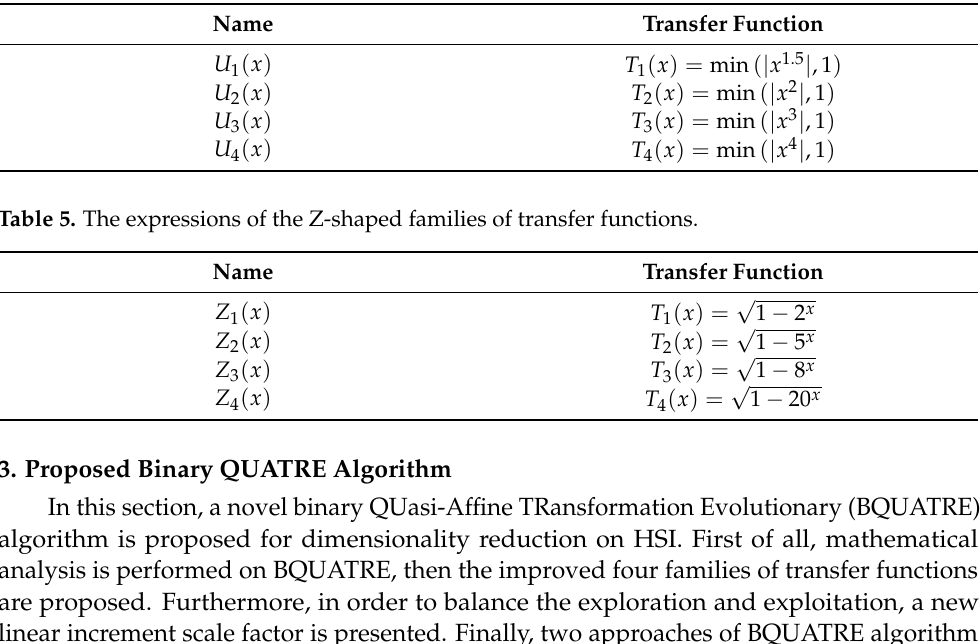
Table 4. The expressions of the U-shaped families of transfer functions.